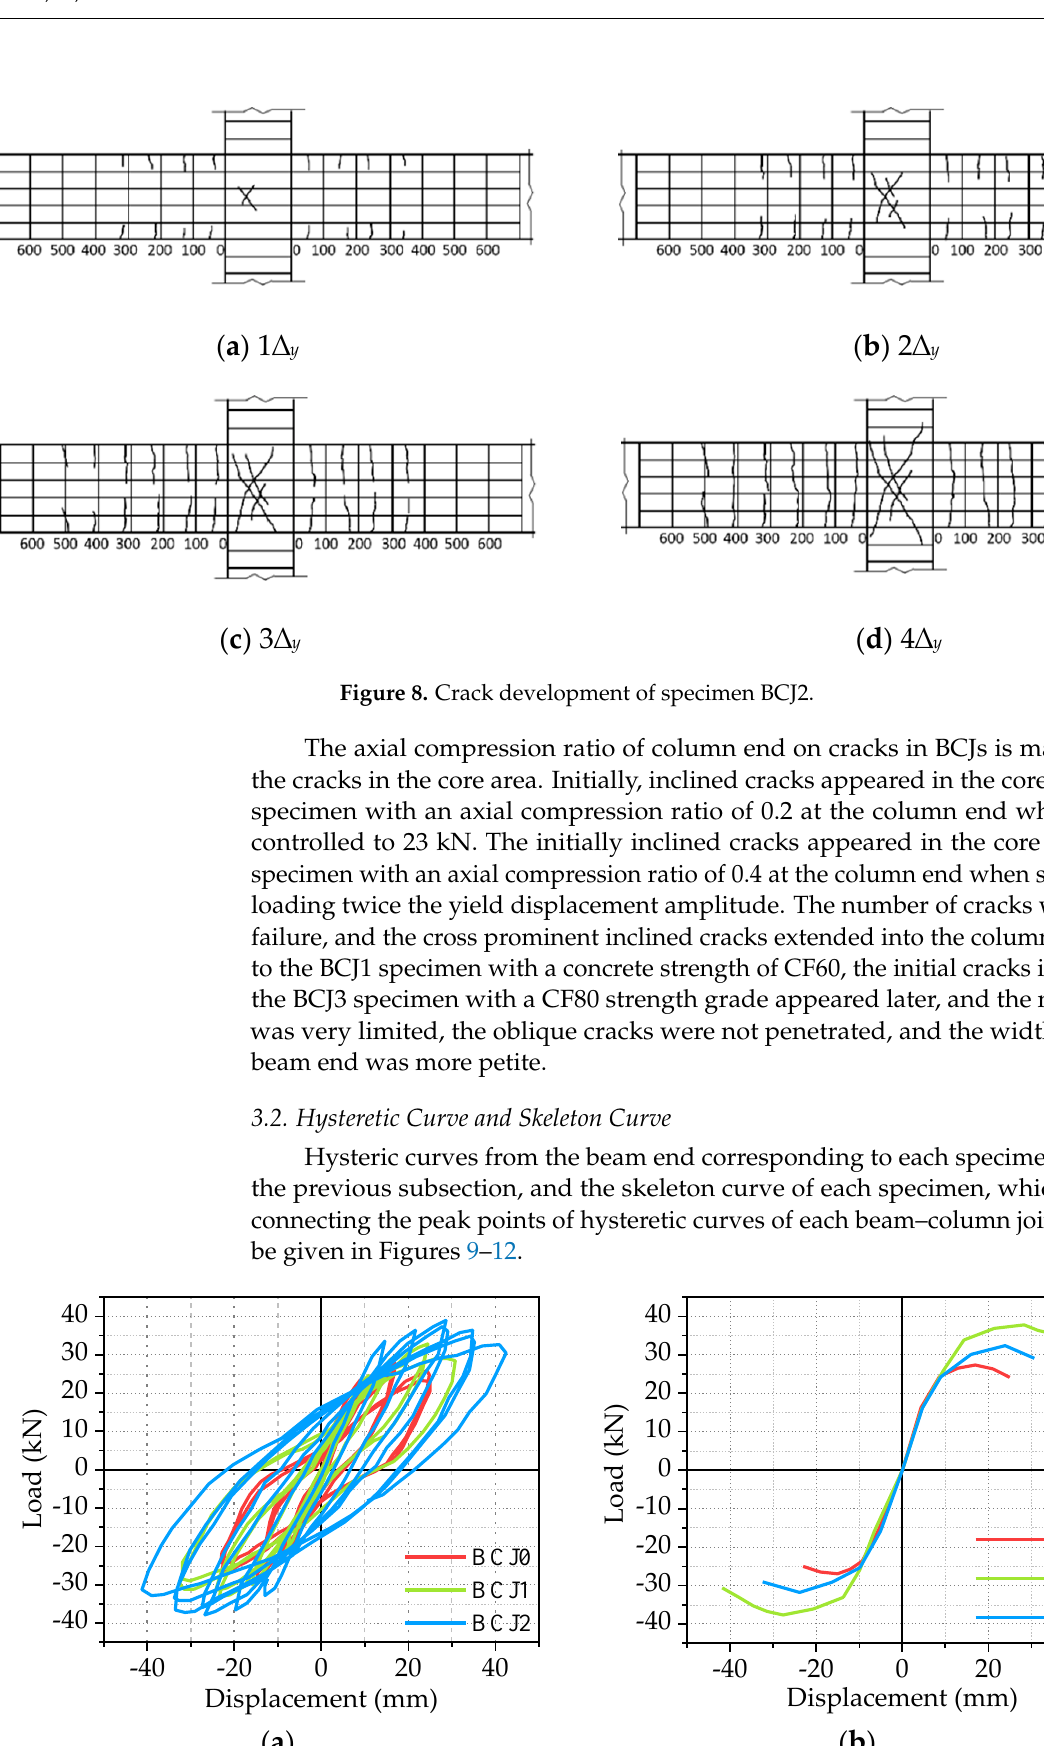
( f ) 6 ∆ y Figure 7. Crack development of specimen BCJ1. As shown in Figure 5b, it can be found that the BCJs with smaller stirrup ratios or volume ratios of steel fiber in the core area, such as the specimens BCJ0, BCJ2, BCJ4, BCJ5, and BCJ6, were subjected to JSF. The failure process and characteristics of these specimens were as follows: when the imposed load was about 75% of the maximum load, the initial inclined crack with a width of about 0.02 mm appeared in the middle of the joint core area along the approximate diagonal direction. After that, with the increase in load amplitude and cycle times, the inclined cracks spread to two diagonal directions, and the cracks at the beam end developed slowly. When the joint was damaged, the core area of the joint formed a main oblique crack, and a series of small oblique parallel cracks appeared near the middle of the core area. At the same time, most stirrups in the core area had yielded, and local spalling of the concrete cover appeared. The cracks at the beam ends were small and tended to develop stably, and the damage was mainly concentrated in the joint core area. With the change in stirrup ratio and volume ratio of steel fiber, a limited difference of crack development in the core area of joints was observed. Figure 8 shows the crack development process of the specimen BCJ2. From Figure 8, it can be seen that the initial oblique crack appeared later, and the crack developed slowly in the specimen BCJ2. When the cracks were destroyed, the same longer cracks with a slight width were observed, and